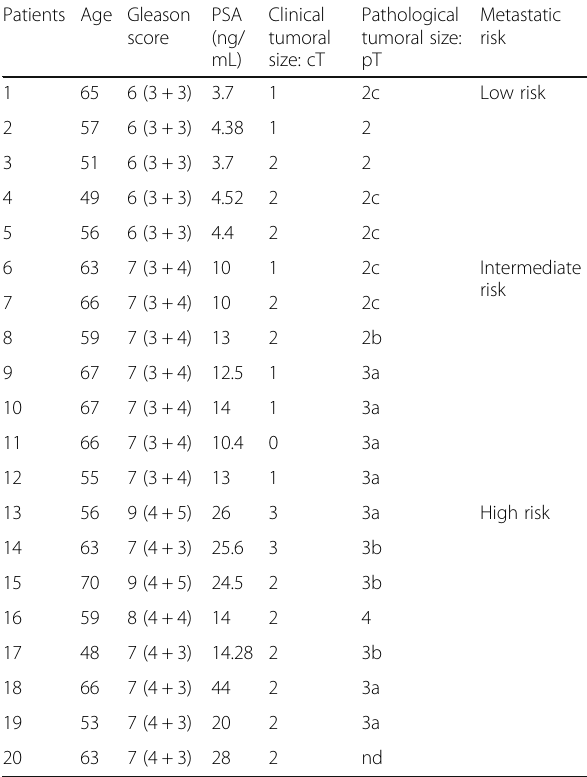
Table 1 Characteristics of the patients from which samples have been used in this study. nd not determined, PSA prostate- specific